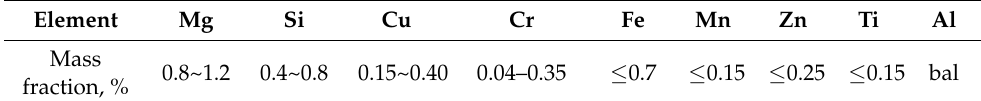
Table 1. Chemical composition of commercial aluminum 6061 (mass fraction,%).